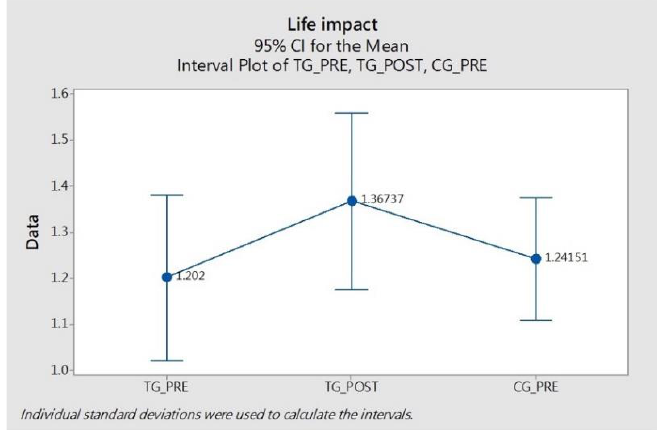
Figure 11. Interval plot for Psychological sensitivity of TG_PRE, TG_POST, and CG.